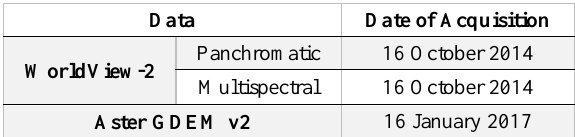
Figure 1. Geographical location of the study